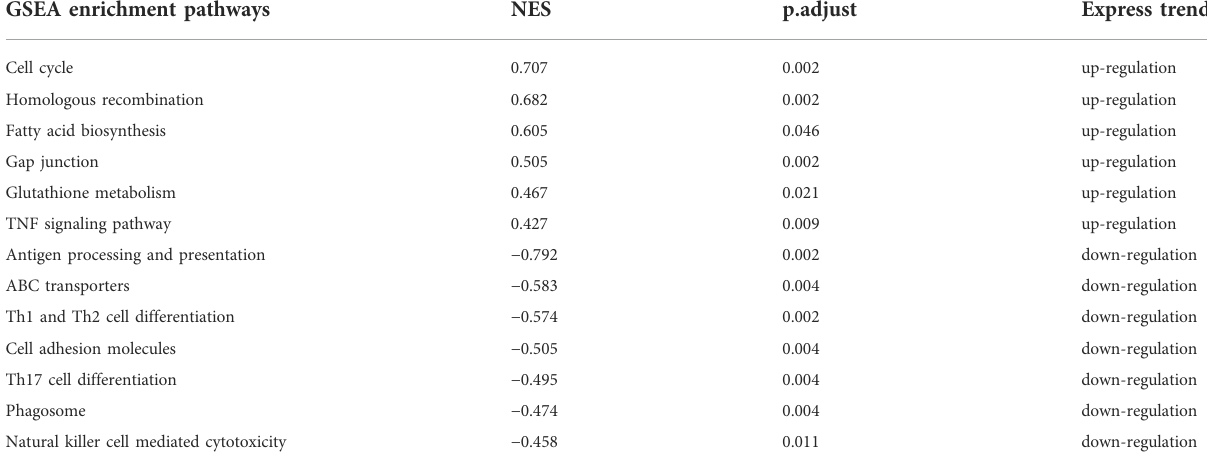
TABLE 2 The unique enrichment pathways in GSEA analysis of genes in 16min – 0min